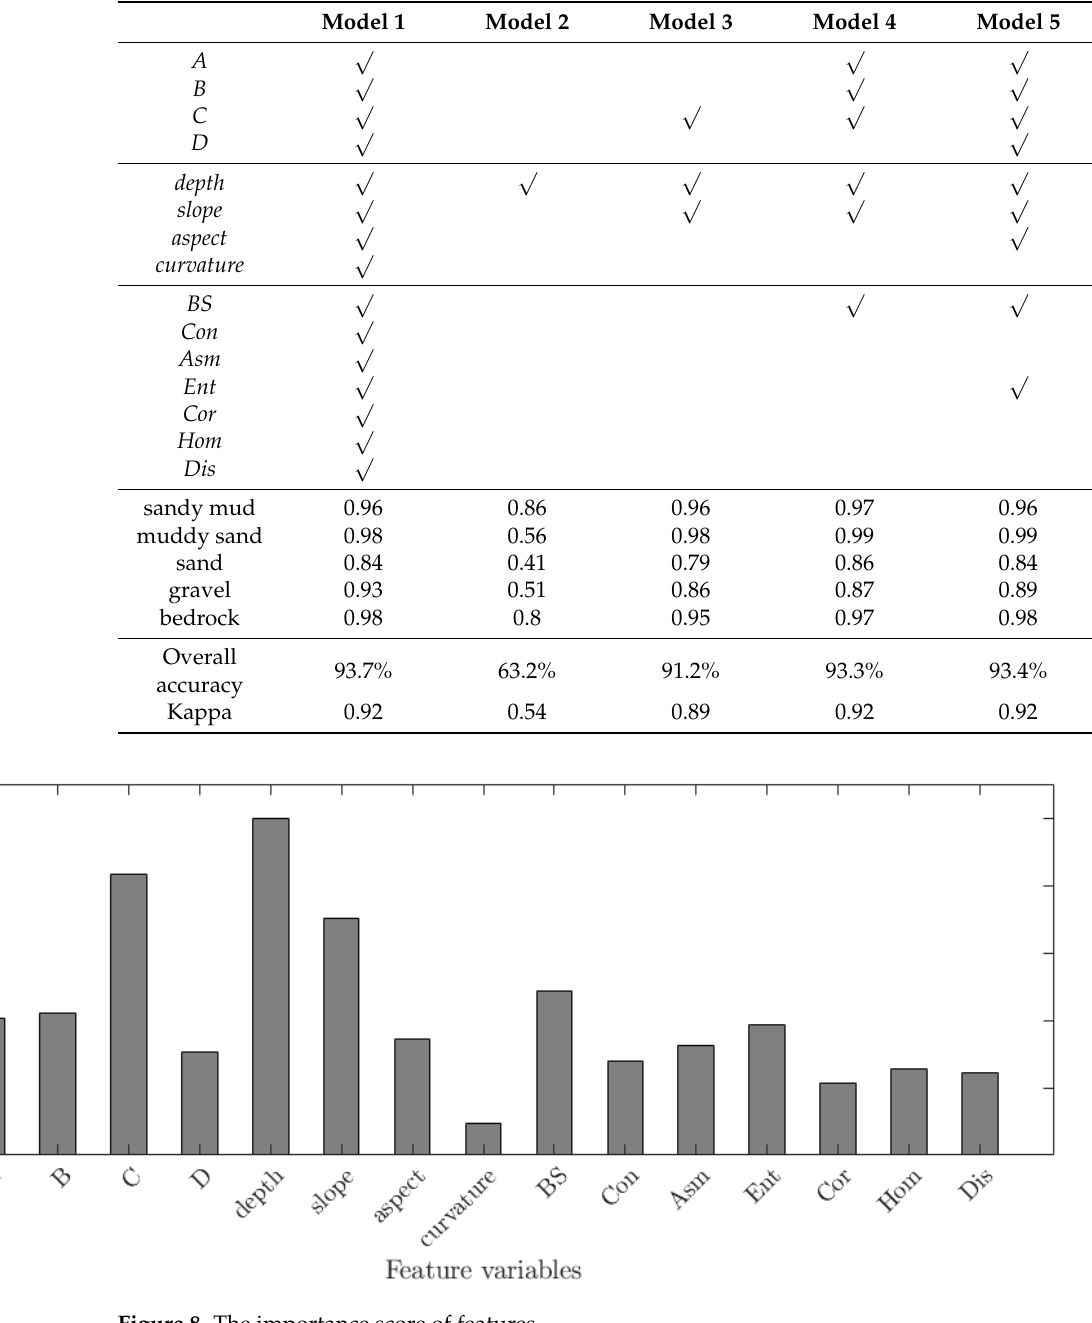
Table 2. Feature sets of different models and classification performance.